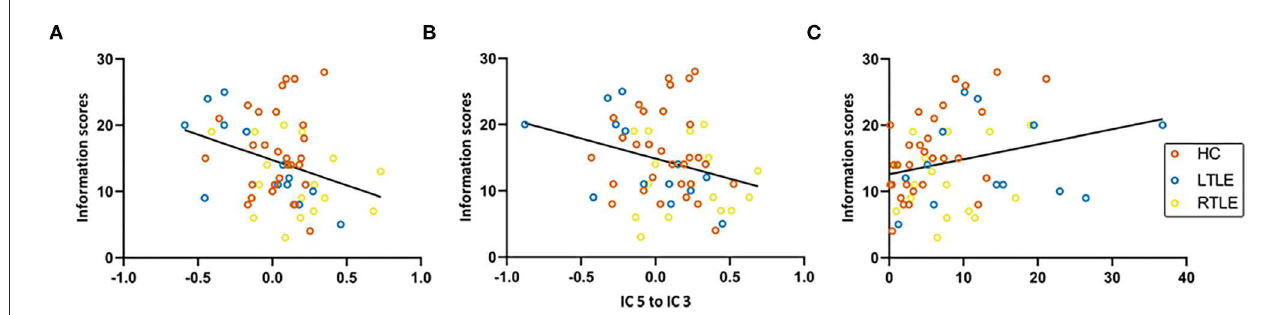
FIGURE4 Correlation analysis. HC, healthy controls; IC, independent component; LTLE, left temporal lobe epilepsy; RTLE, right temporal lobe epilepsy. (A) Functional connectivity from IC 3 to IC5. (B) Functional connectivity from IC 5 to IC 3. (C) Degree centrality of right lobule III.